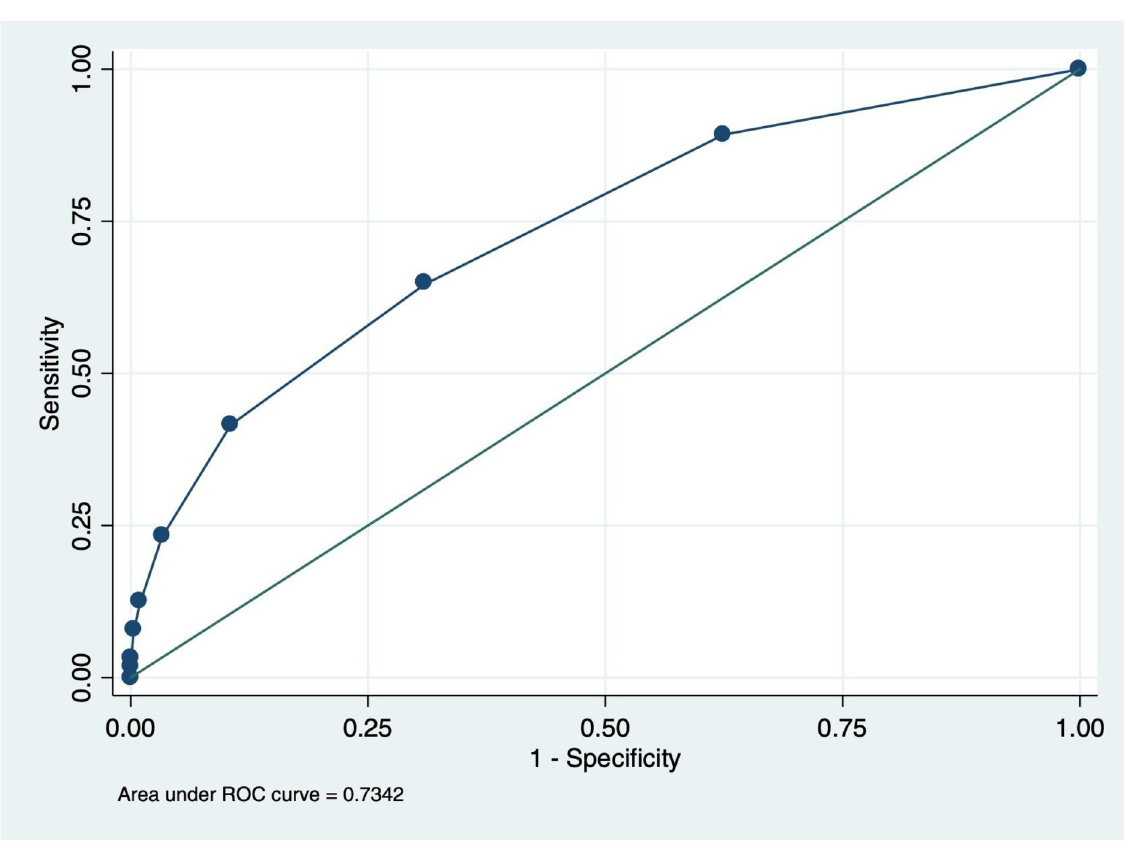
Fig 2. Receiver operating characteristic curve for each cut-off for the full (12) item screening tool, ages 2–19 years.